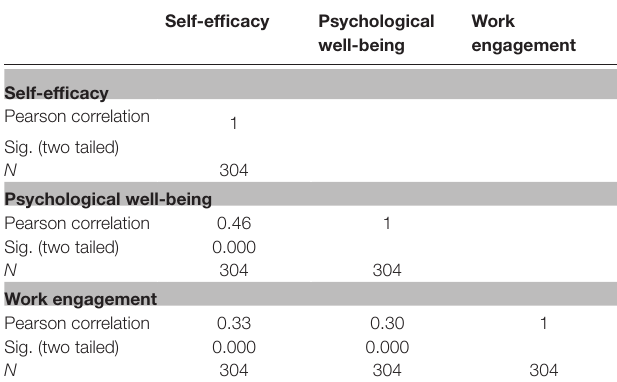
TABLE 4 | Pearson correlation results.